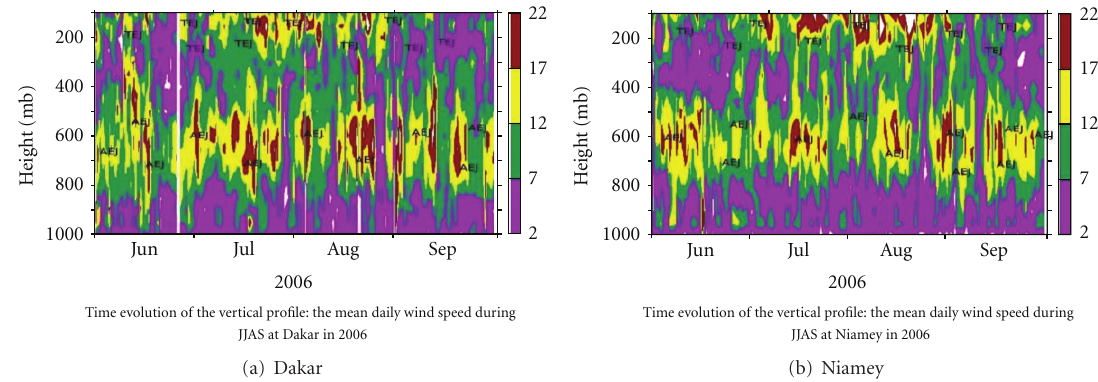
Figure 7: Wind speed profiles in Dakar and Niamey at 0000 UTC and 1200 UTC during JJAS 2006.